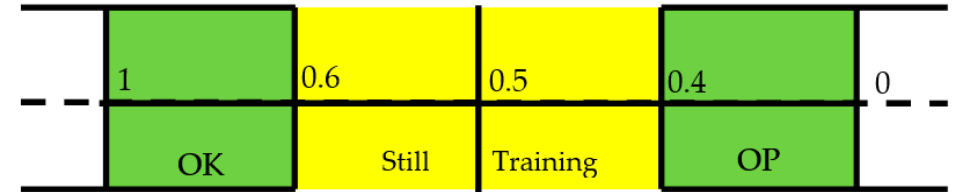
Figure 6. Error threshold diagram. Green indicates the catchment areas for classifying OK or OP. Yellow indicates excluded ambiguous results.